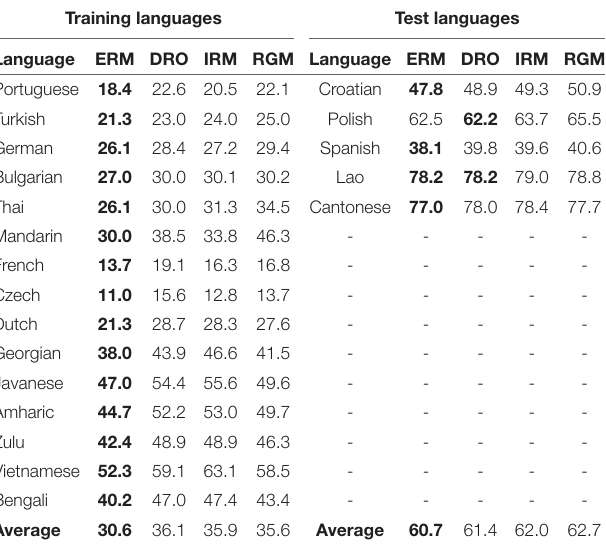
TABLE 1 | Sources of data used in our cross-lingual experiment. Language